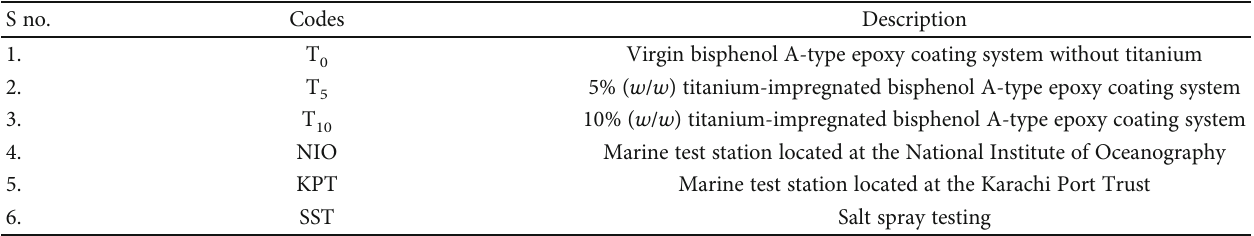
Table 1: Codes for some frequently used terms of this study.